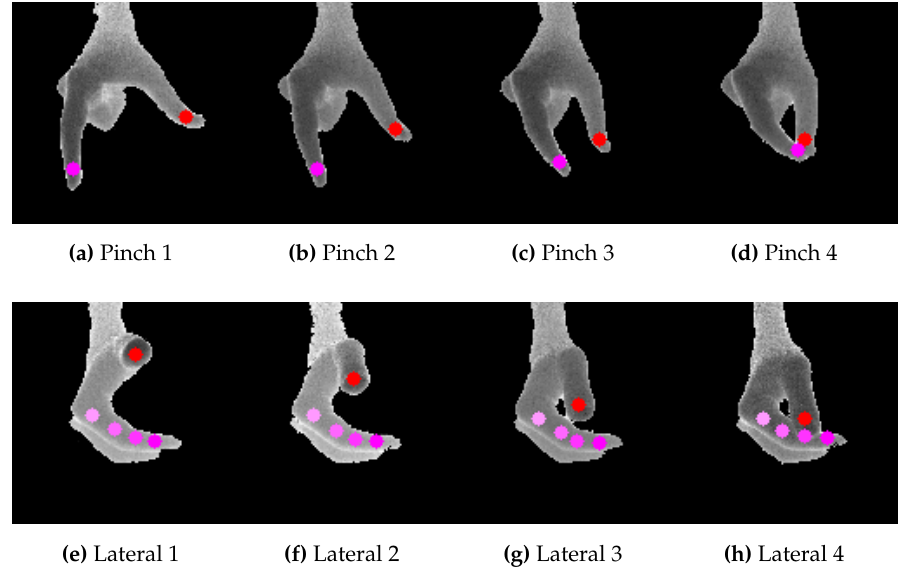
Figure 3. Pinch ( a–d ) and lateral ( e–h ) grasping sequences with overimposed fingertips as estimated by our VPE